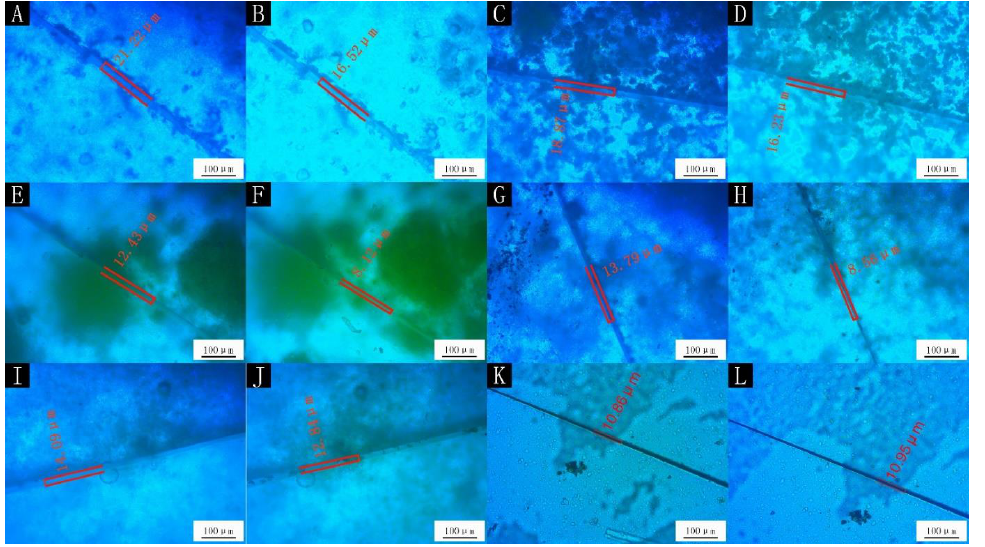
Figure 9. SEM of coating film: ( A ) Span-80, ( B ) SDBS, ( C ) OP-10, ( D ) Tween-80, ( E ) SDS, ( F ) no mi- Figure 9. SEMofcoatingfilm: ( A )Span-80, ( B )SDBS,( C )OP-10, ( D )Tween-80, ( E )SDS,( F )no microcapsules. crocapsules.